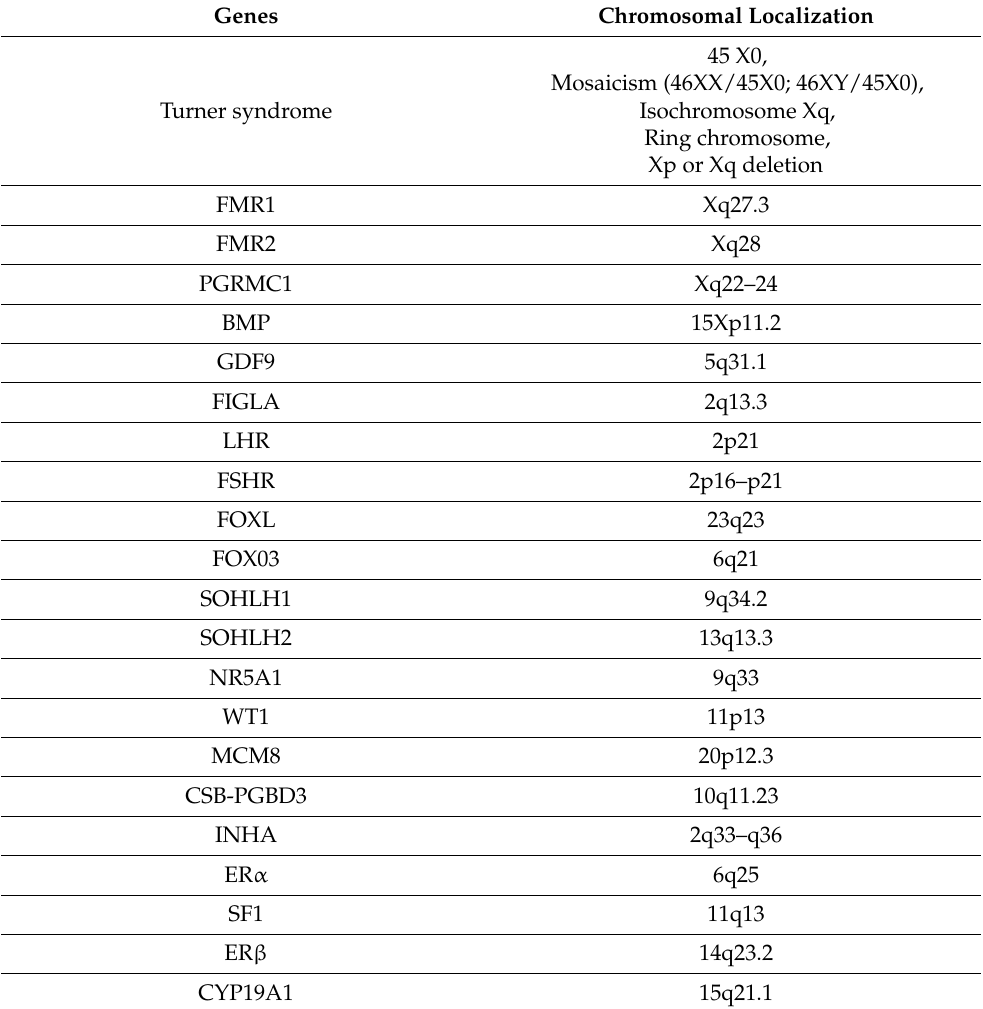
Table 1. Genetic causes of premature ovarian insufficiency